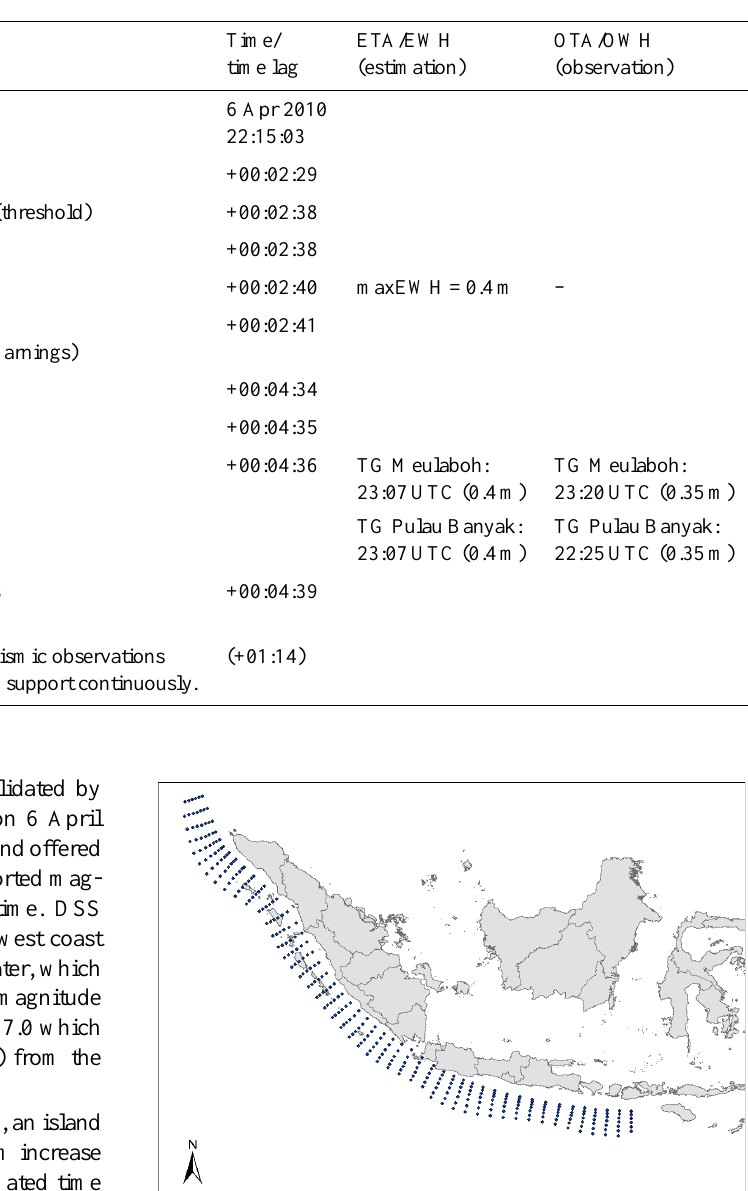
Table 2. Sequence of events during the 6 April 2010 Sumatra earthquake incident.